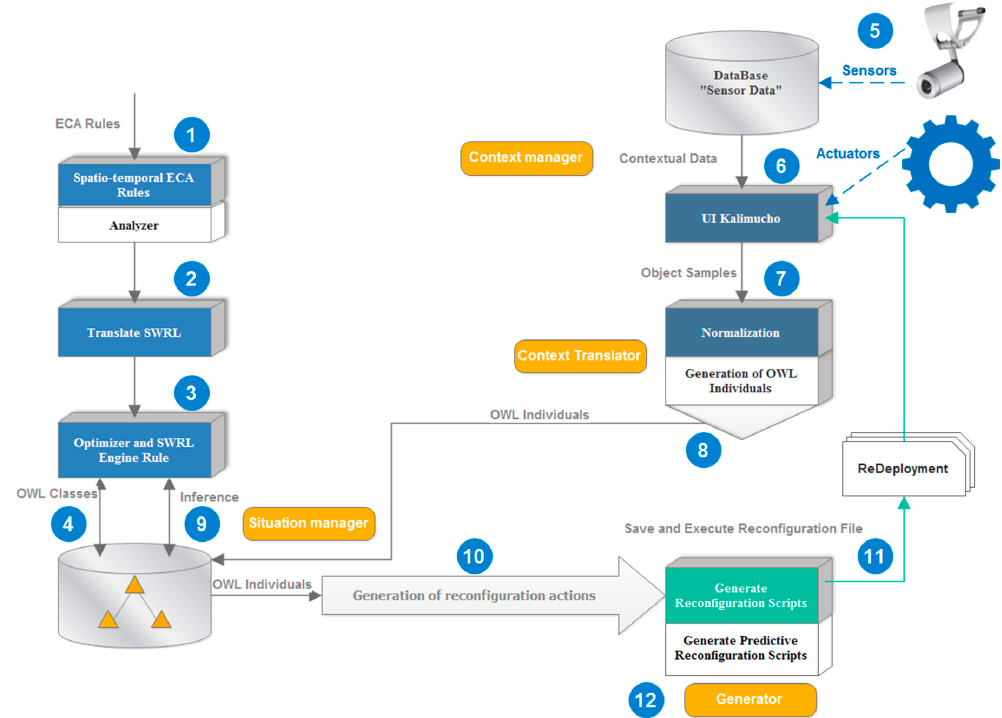
Figure 2. Model of the Kali-Smart adaptation platform. ECA (Event Condition Action); SWRL (Semantic Web Rule Language); OWL (Web Ontology Language).